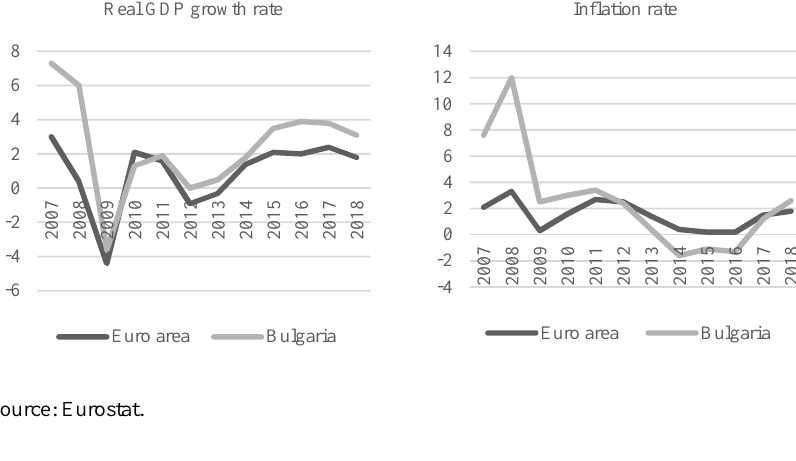
Figure 1. Real GDP growth rate and inflation rate in Bulgaria and the euro area